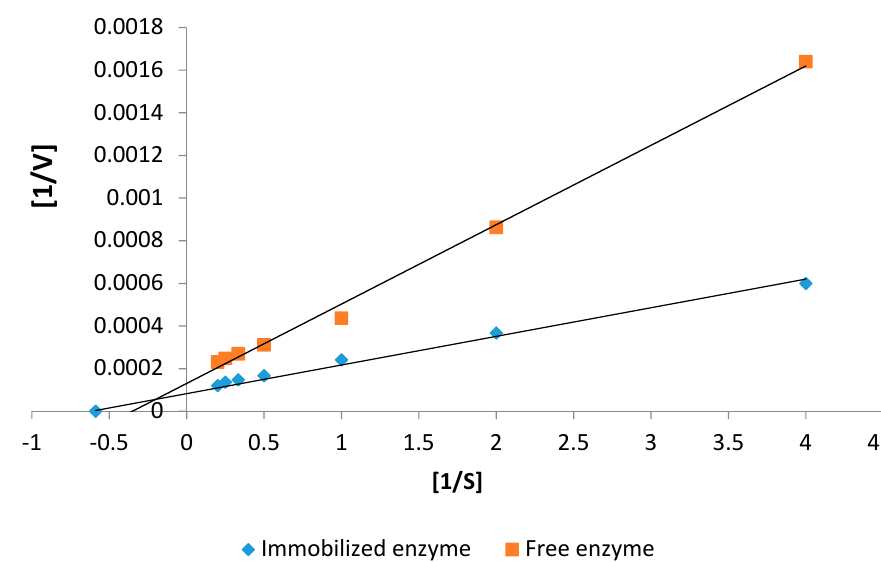
Figure 8. Estimation of kinetic parameters of the free and immobilized NPST-AK15 protease. The enzyme activity was measured at various casein concentrations (1.0–10.0 mg/mL) at pH 11 and 60 °C. The K m and V max values were determined using linearized Lineweaver-Burk plot. S: Substrate concentration; V: Protease specific activity